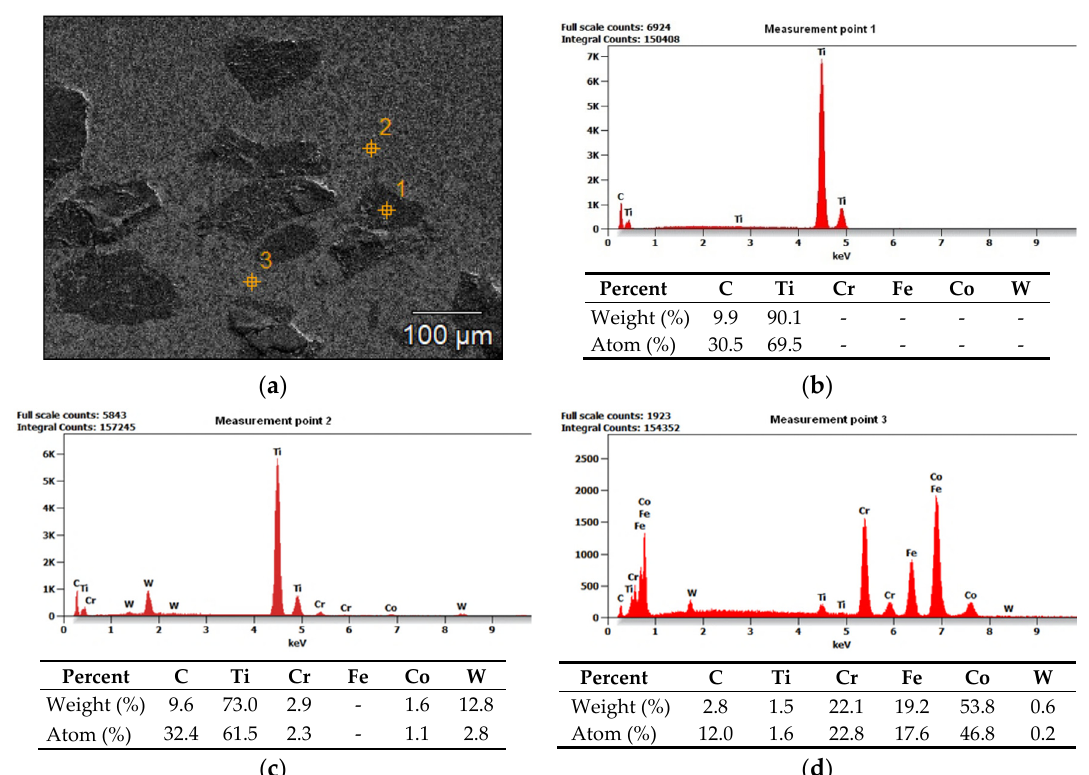
Figure 12. Results of the microanalysis of the chemical composition of the surface layer (PPTAW metal deposition method, Co3+TiC+PD-W composite powder) deposited on structural low-alloy steel AISI 4715: ( a ) area subjected to analysis, ( b–d ) diagram of the energy of scattered X-radiation with energy lines present in the area of components (chemical elements (ceramic particle of TiC and metal matrix)) subjected to analysis.